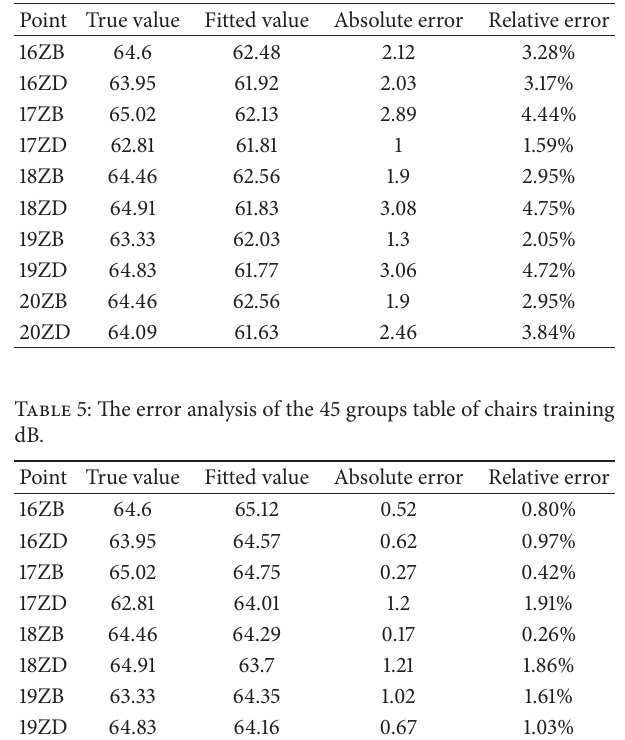
Table 4: The error analysis of the 45 groups back of chairs training dB.